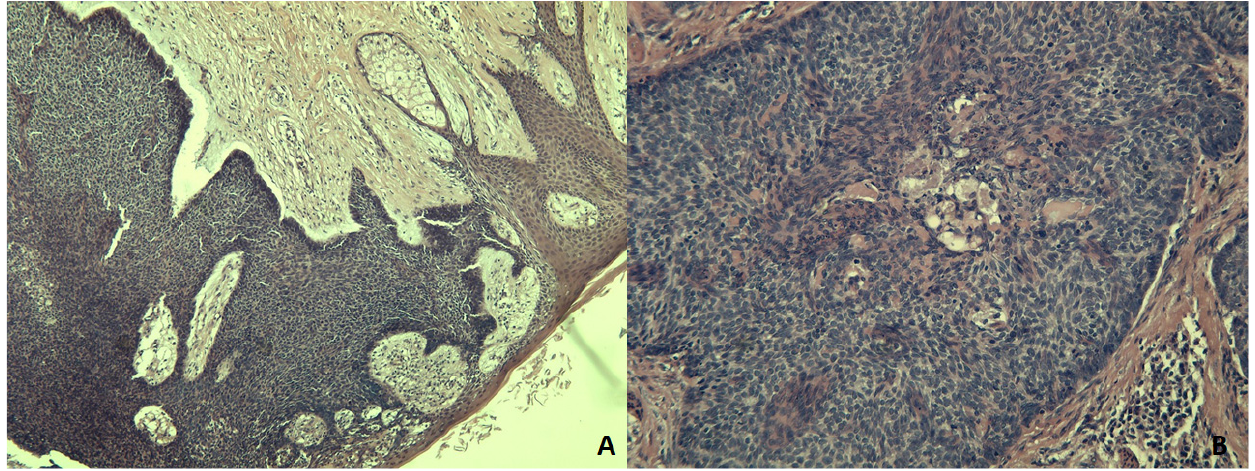
Figure 2. BSCC. ( A ): Islands of basaloid cells with peripheral palisading, limit with the overlying epidermis (HEX50) ( B ): Evidence of squamous differentiation in the basaloid island in the center of this image (HEX100).